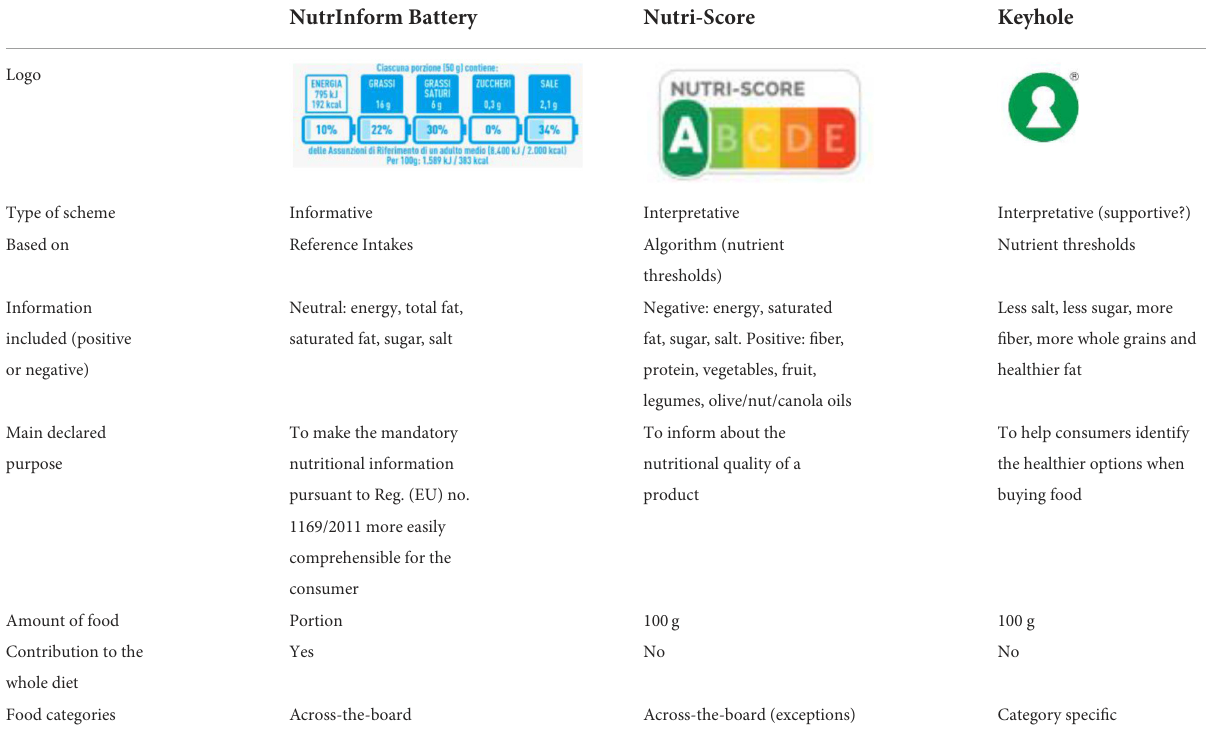
TABLE 1 Main characteristics of three FOPL